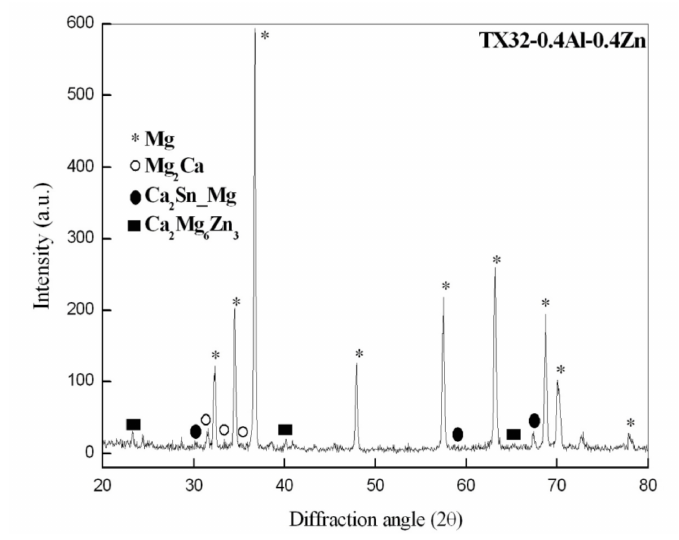
Figure 2. X-ray diffraction (XRD) spectrum of as-cast TX32-0.4Al-0.4Zn (TXAZ3200) alloy.